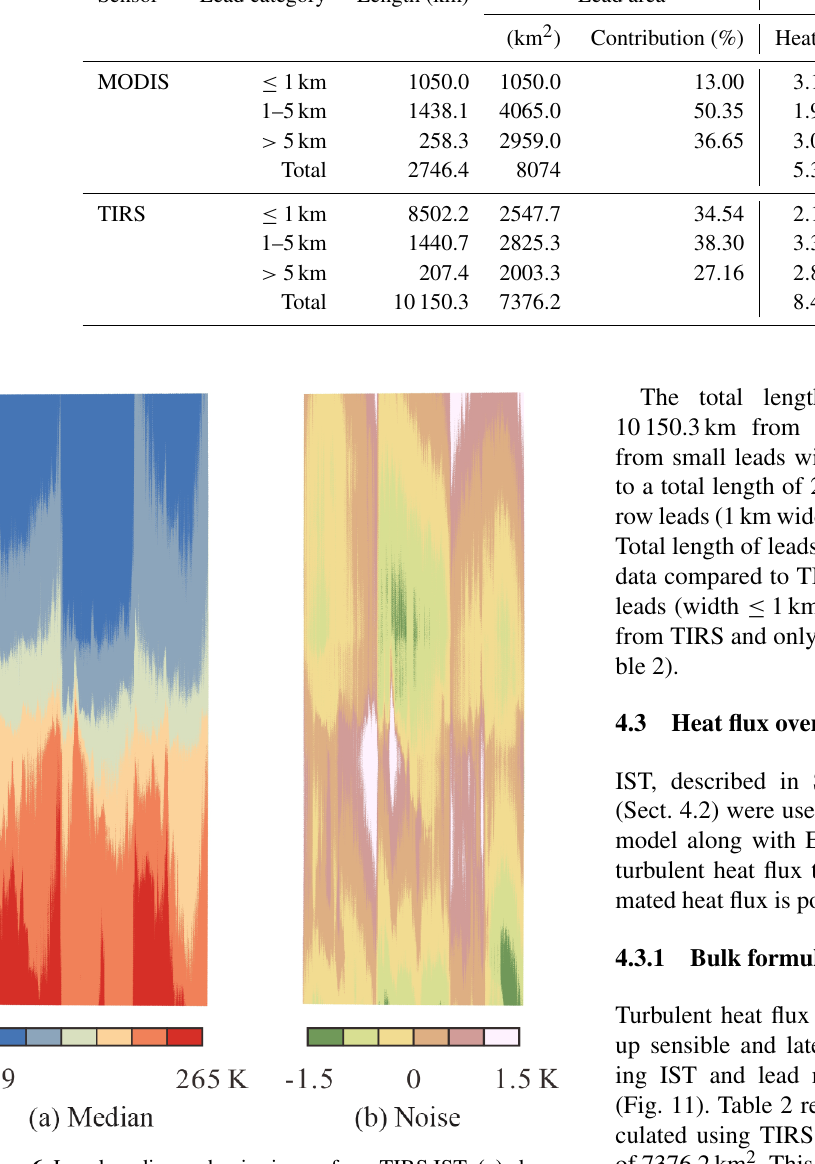
Figure 6. Local median and noise image from TIRS IST: (a) along- track median temperature map and (b) noise image by detrending of median temperature